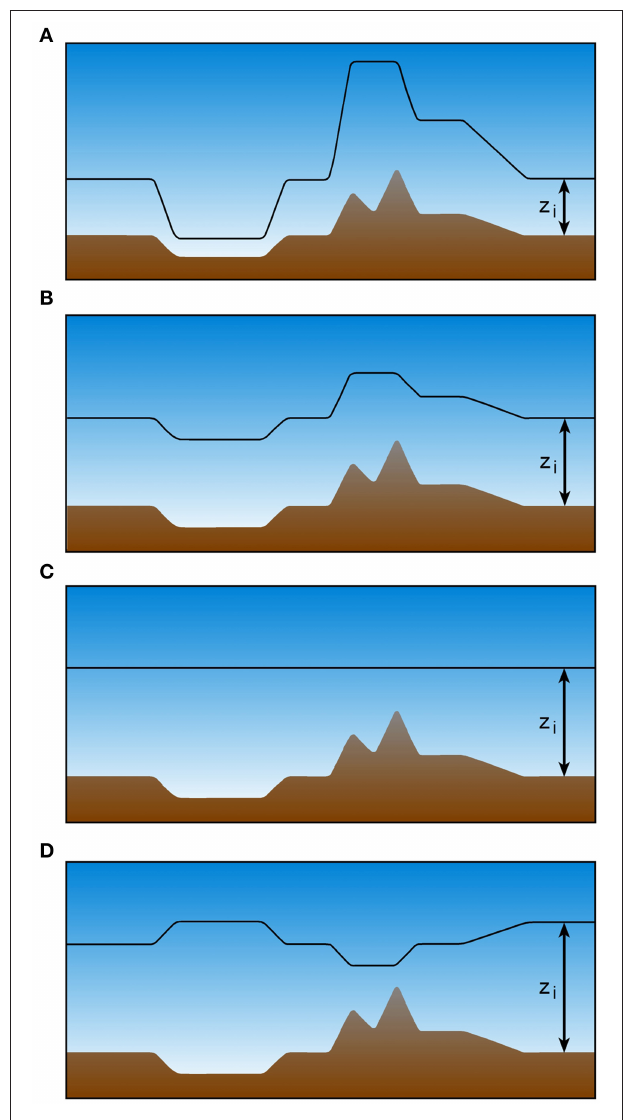
FIGURE 10 | Schematic illustration of four types of CBL top behavior. (A) Hyper terrain following, (B) terrain following, (C) level, (D) contra-terrain following (after Stull, 1992). The solid black line indicates CBL depth z i